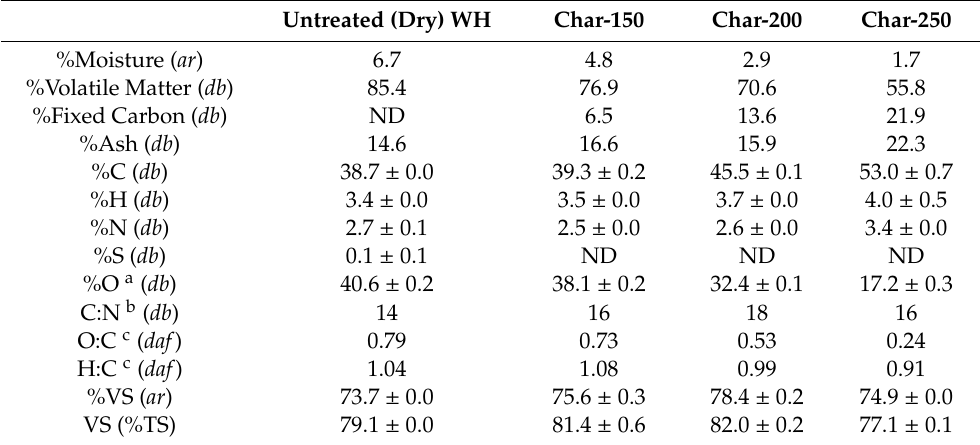
Table 2. Proximate and ultimate composition of untreated water hyacinth (WH) and hydrochars from hydrothermal carbonisation